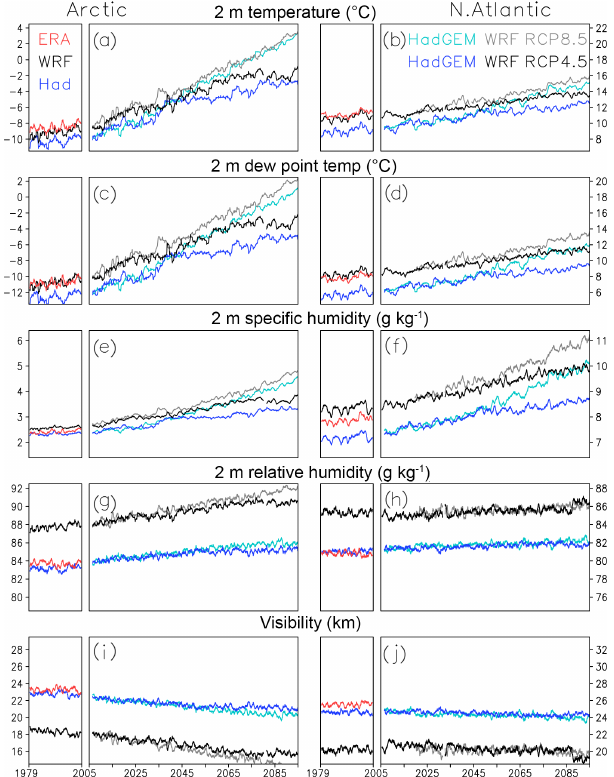
Figure 2. Simulated HadGEM2 (blue), WRF (black), and analyzed ERA (red) areal average trends in Arctic (left panels) and North Atlantic (right panels) (a, b) air temperature ( ◦ C), (c, d) dew point temperature ( ◦ C), (e, f) specific humidity (gkg − 1 ), (g, h) relative humidity (%), and (i, j) visibility (km) at 2m above the surface. The WRF and ERA averages are taken over fixed ocean domains (regardless of sea ice) of 15 (Arctic) and 13 (North Atlantic) million square kilometers. The HadGEM2 domains are about 25% larger and include coastal overlap as these data are at lower resolution. Note that ordinate scales differ on the left and right, but their spans are